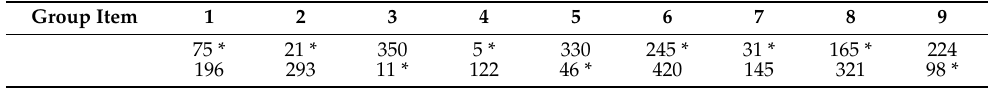
Table 10. Random grouping for the electronic devices dataset.